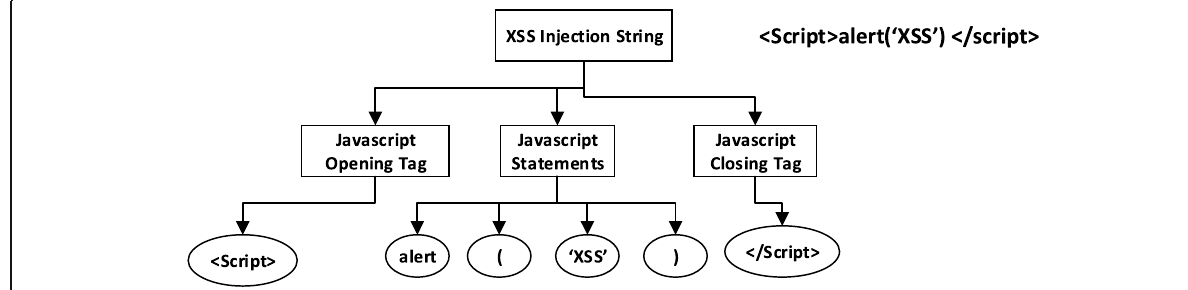
Fig. 6 Parse tree to depict XSS injection